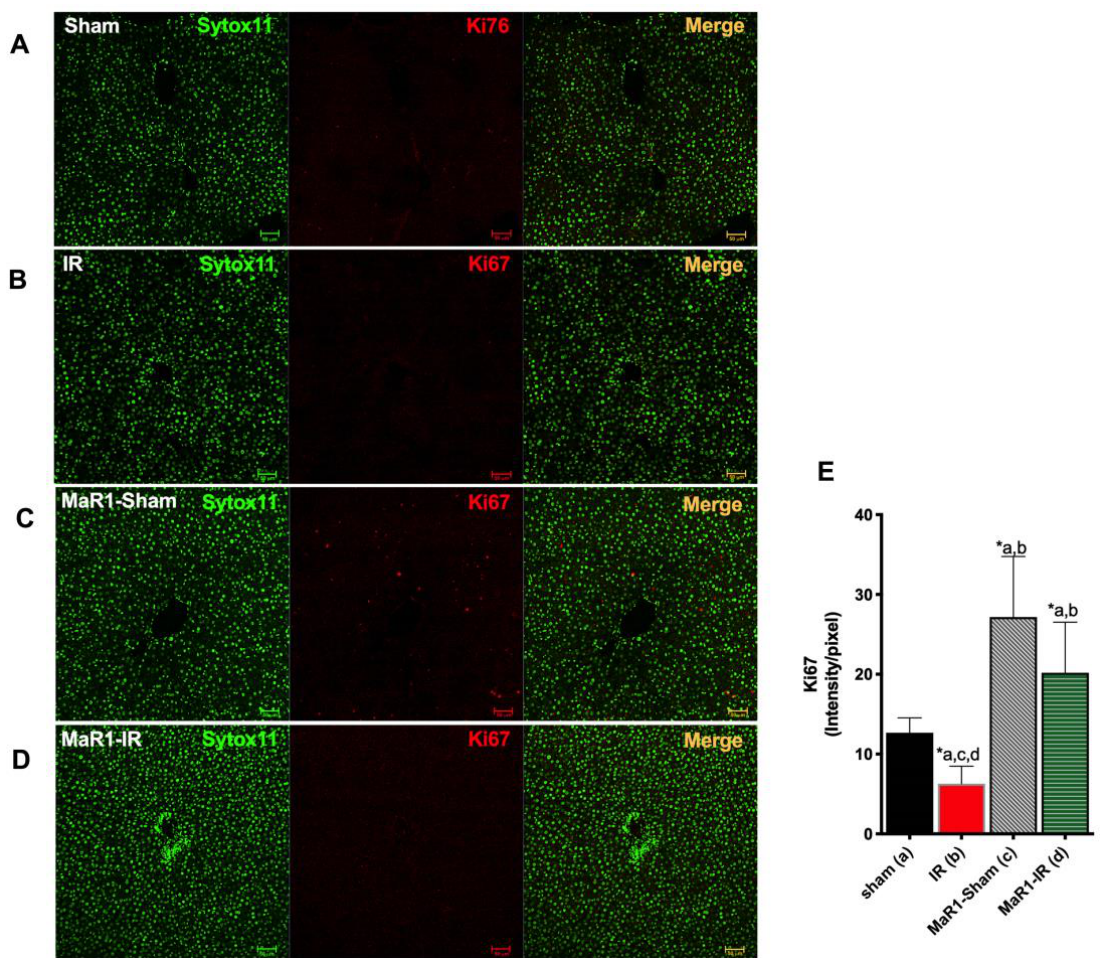
Figure 4. Effect of MaR1 on cell proliferation measure thought Ki67 immunofluorescence red signal and nuclei in green (Sytox TM Green 11). Representative images of ( A ) sham, ( B ) IR, ( C ) MaR1-IR, and ( D ) MaR1-IR. ( E ) The Ki67 signal intensity was evaluated. The plot is represented as mean ± SEM, n = 4 rats per experiment, Image fields measured per rats >6. Significance was assessed by one-way ANOVA and the Tukey’s post-test. Asterisk indicates p < 0.05, and the letters identify the experiments that are compared and present this statistical difference. Scale bar indicates 50 µm.